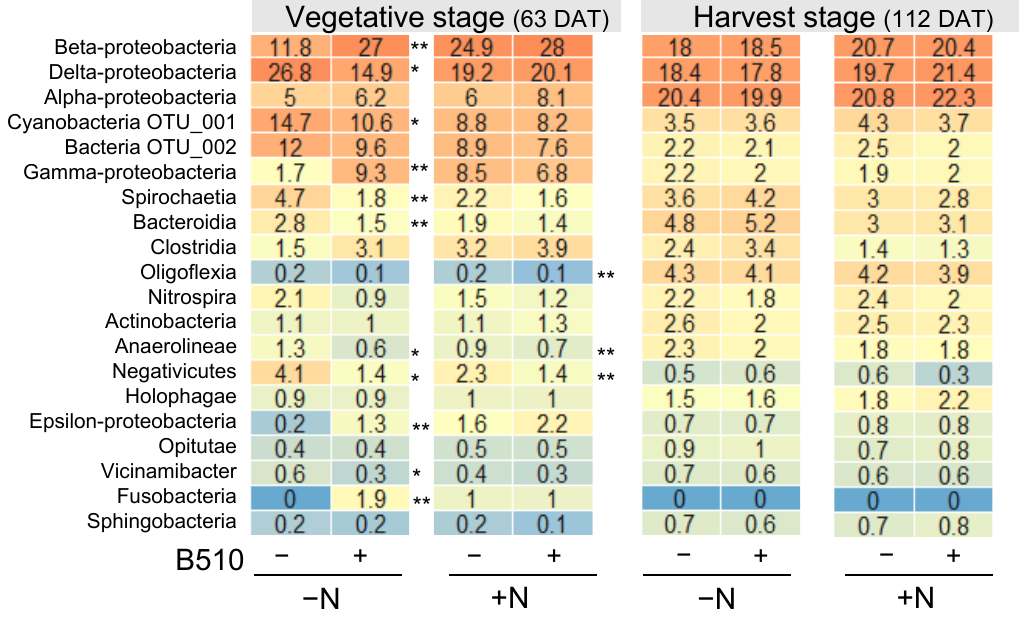
Figure 2. Heat Map of the top 20 bacterial species associated with rice roots at the vegetative stage (63 DAT) and harvest stage (112 DAT). The heat-maps show the relative abundances of bacterial operational taxonomic units (OTUs) at the class level from rice plants inoculated with B510 (+) and without B510 ( − ) and with supplemental nitrogen fertilizer (+N) and without N-fertilizer ( − N). The color of the heat-map indicates the relative abundance from high (red) to low (blue). The asterisks identify significant differences between B510-inoculated (+) and without B510 ( − ) analyzed by the unpaired two-tailed Student’s t-test (* p < 0.05, ** p < 0.01).